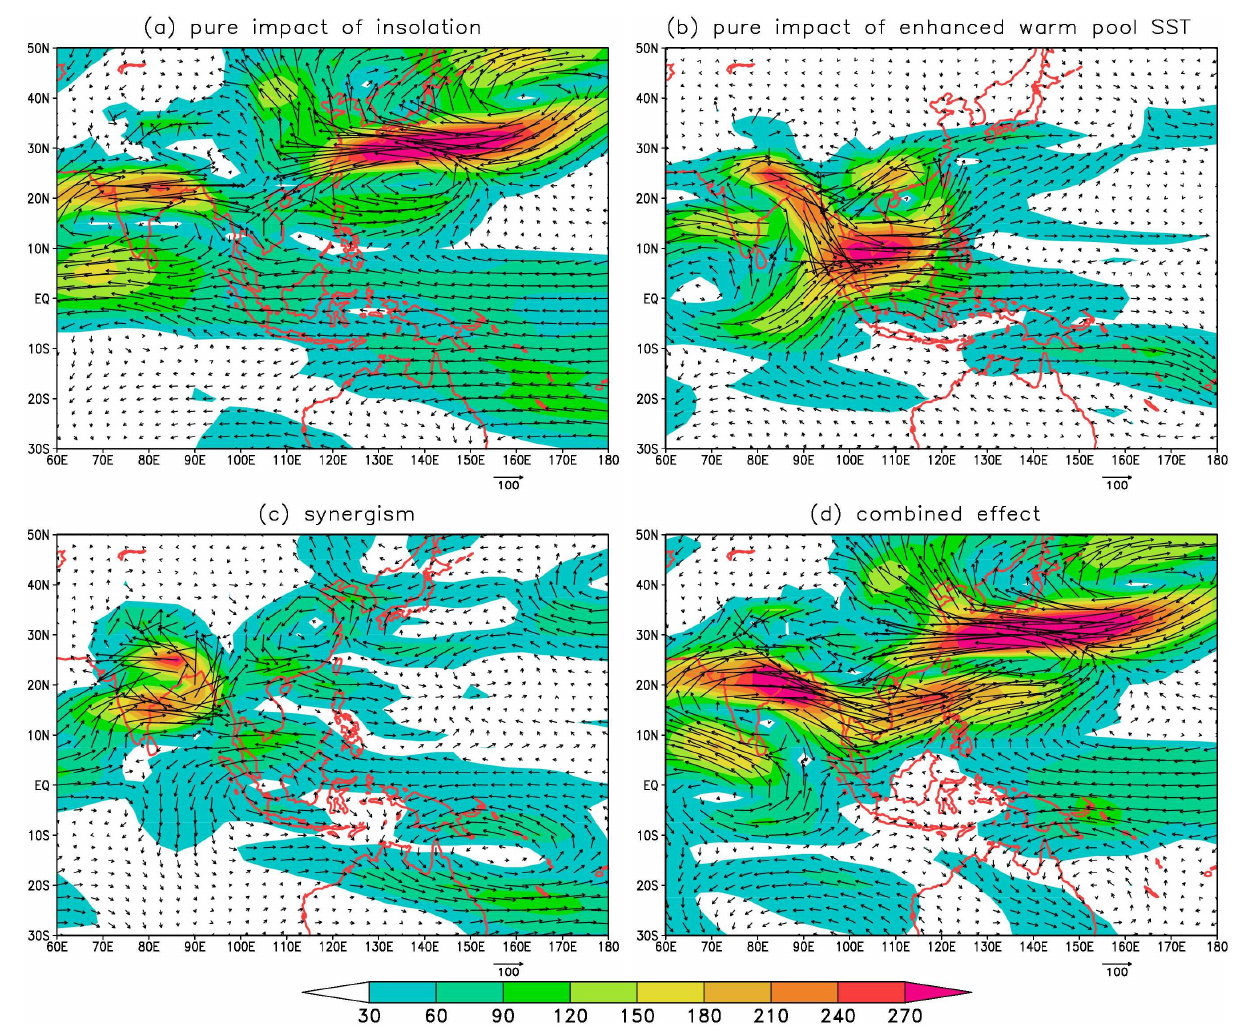
Figure 8. Same as Figs. 2, 4 and 7 except for summer vertically integrated moisture transport anomaly (Kgm − 1 s − 1 ) in the whole tropo-